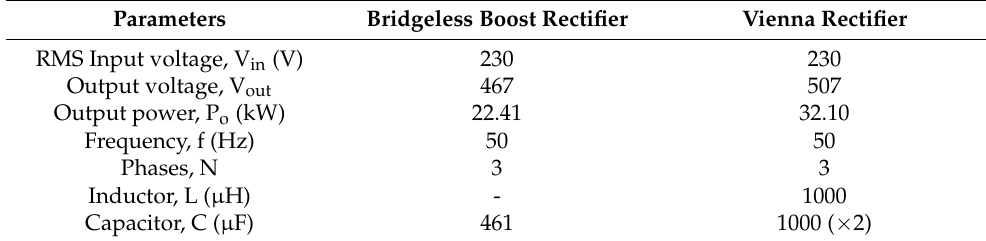
Table 3. Description parameter values of AC–DC rectifiers for MATLAB